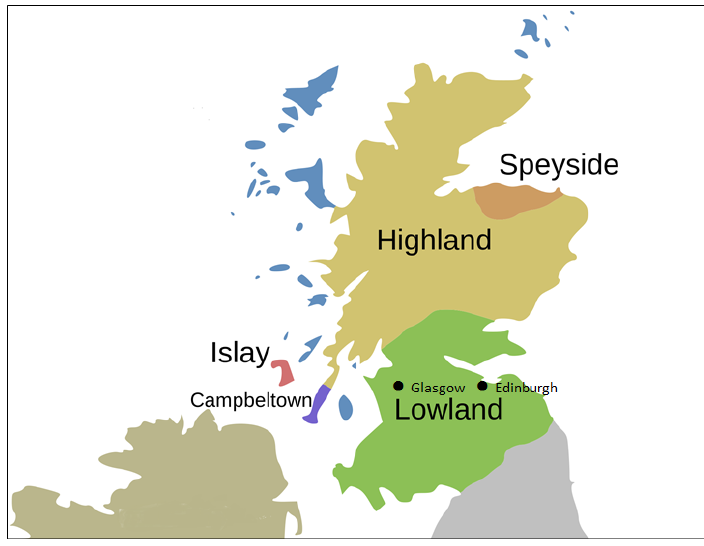
Figure 1. The Scotch whisky distilling regions. Adapted from original drawn by User:Briangotts as Image: Scotch regions.png and converted to SVG by w:User:Interiot under Creative Commons Licence. For a detailed map see http://www.scotch ‐ whisky.org.uk/news ‐ publications/publications/ documents/the ‐ world ‐ of ‐ scotch ‐ whisky ‐ map ‐ 2015/#.VqjAzI_XJmA.